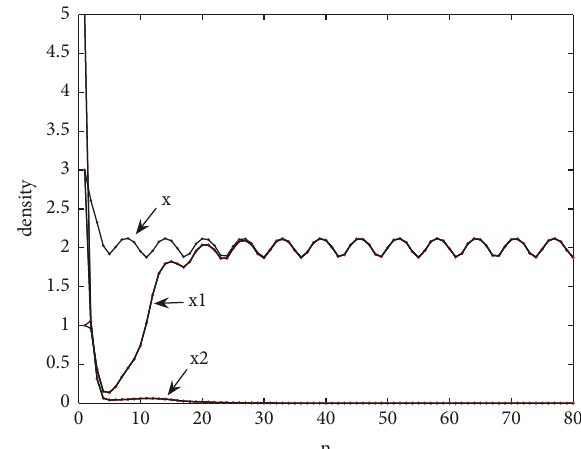
Figure 1: Dynamic behaviors of species 𝑥 1 and 𝑥 2 in (100) with initial values 𝑥 1 (0) = 1, 3, 5 and 𝑥 2 (𝜗) = 1, 3, 5 for 𝜗 = −2,−1, 0 , respectively; 𝑥 is a solution of